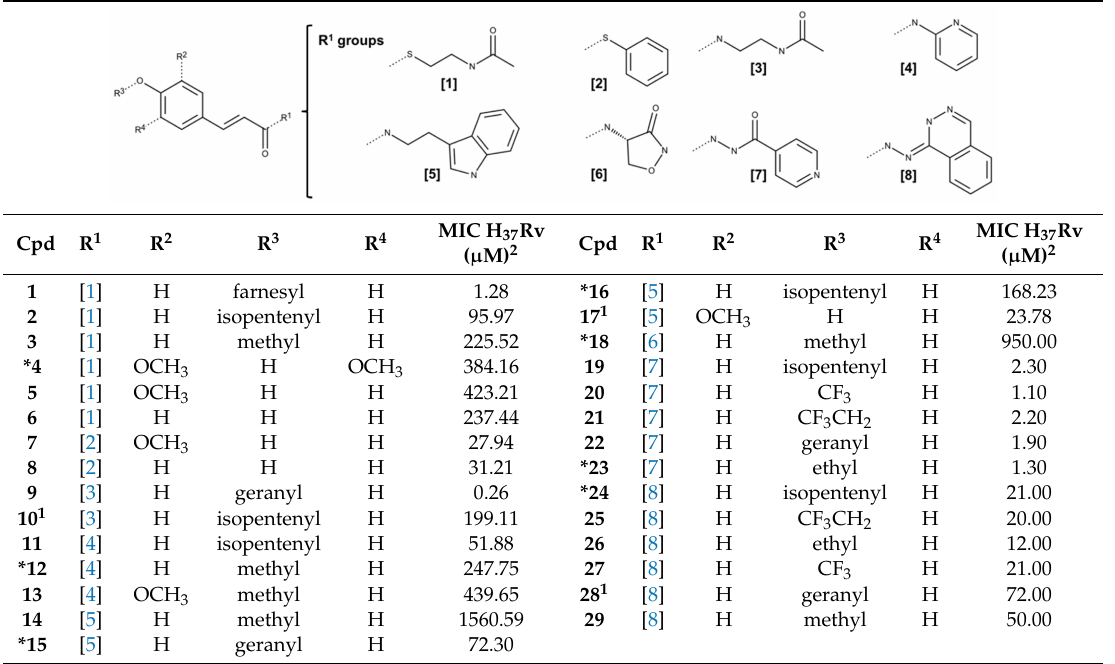
Table 1. Structure of the cinnamic acid derivatives (CAD) used to derive the multiple linear regression (MLR)-based model. Compounds marked with an asterisk belong to the test